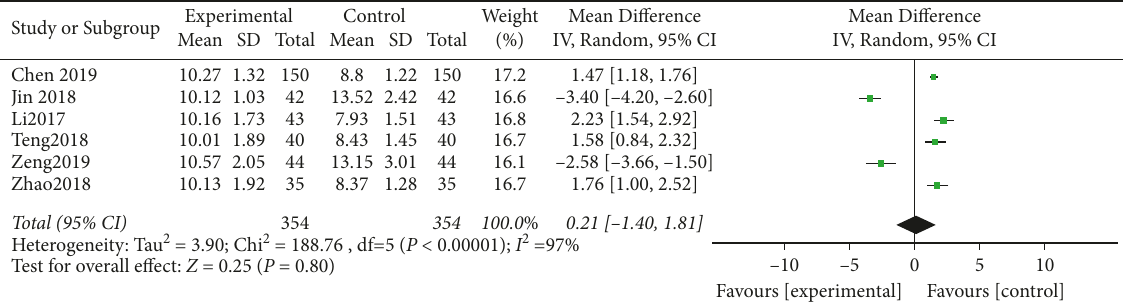
Figure 7: Forest analysis map of the condition of slab after treatment.